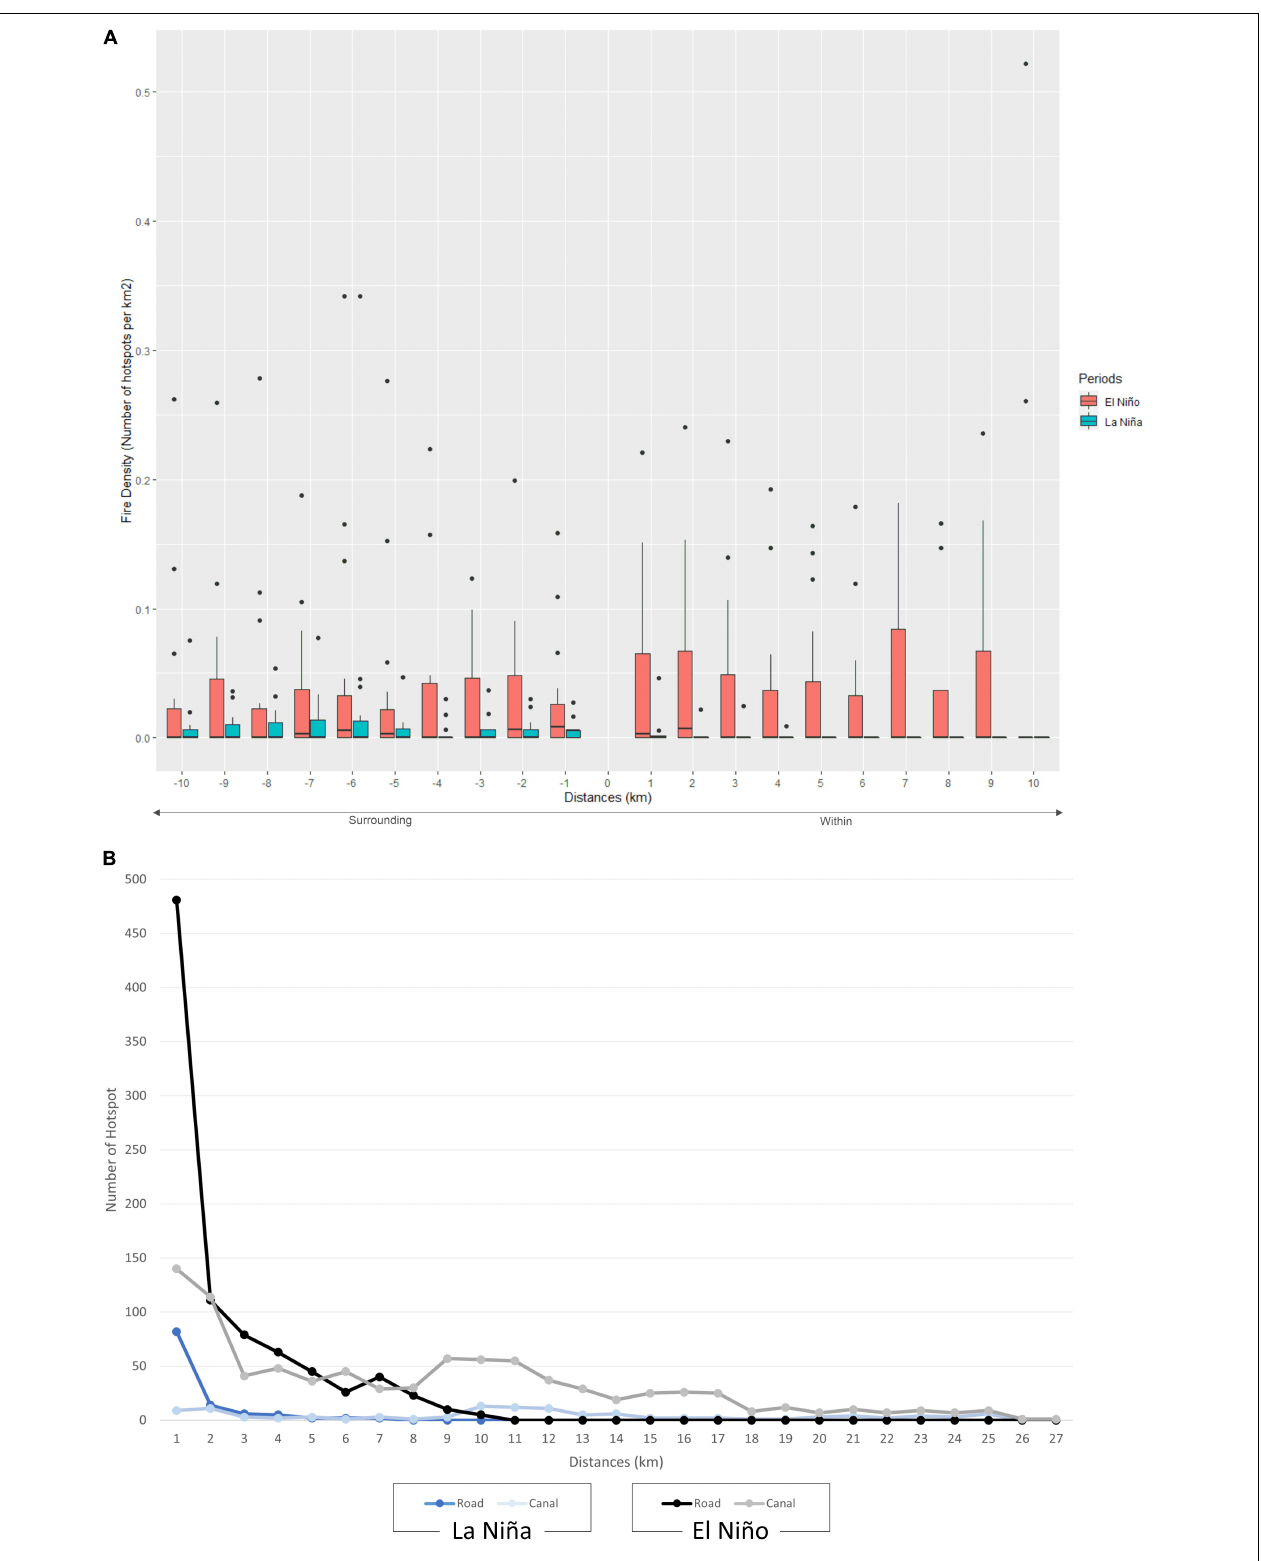
FIGURE 5 | Boxplot of fire density at each distance form border during La Niña and El Niño years within and surrounding the reserve border (A) and frequency of hotspot as function of distance from canals and roads (B) .